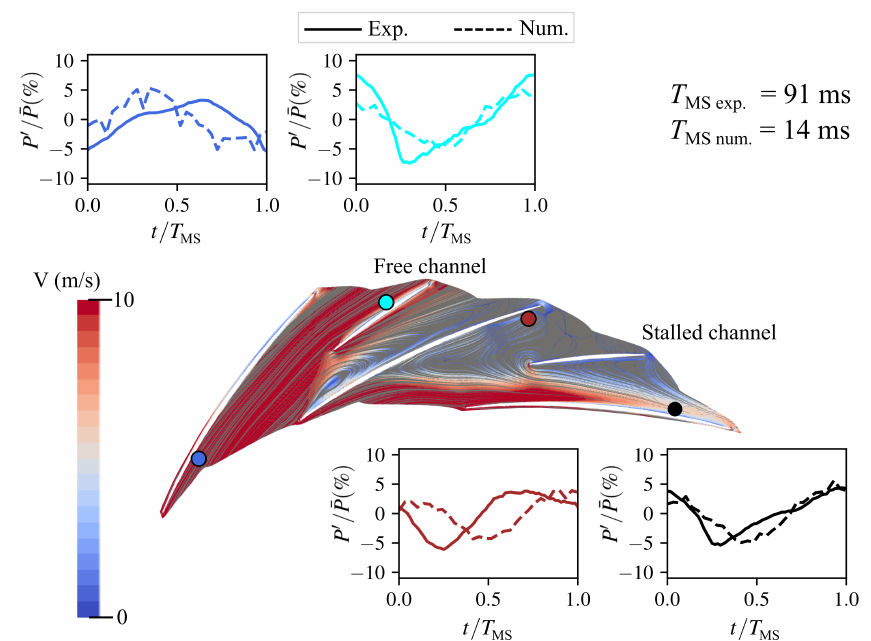
Figure 10. Comparison of pressure fluctuations at the radial diffuser hub during an alternate stall period at OP2 between experimental and numerical